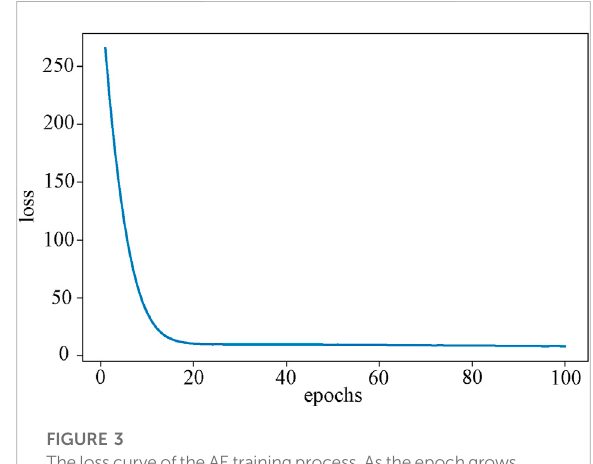
FIGURE 3 ThelosscurveoftheAEtrainingprocess.Astheepochgrows, training tends to converge around epoch